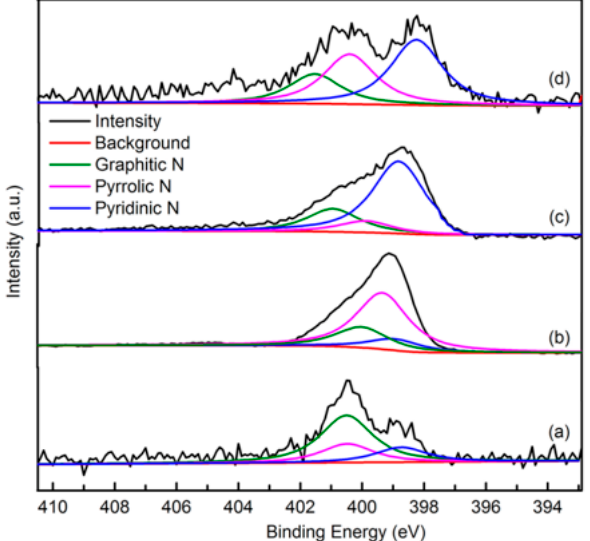
Figure 4. Narrow scanning N 1s X-ray photoelectron spectroscopy (XPS) spectra of (a) green petroleum coke, (b) N-GLPs 350 2 , (c) N-GLPs 550 2 , and (d) N-GLPs 750 2 .